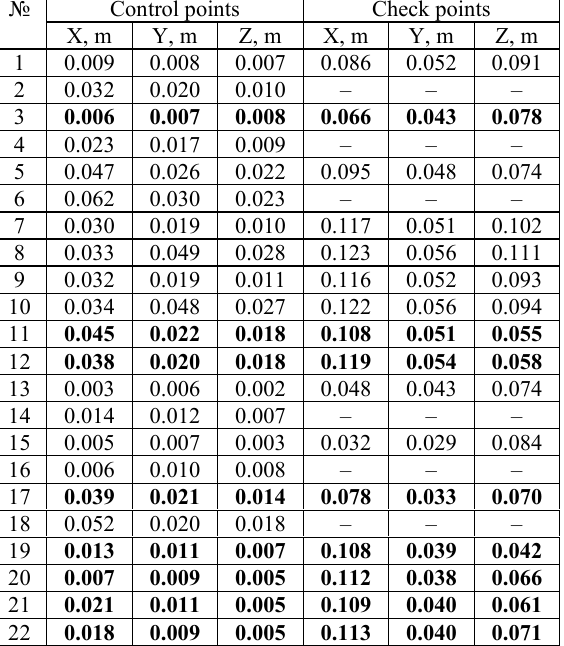
Table 3. RMS errors of generated photogrammetric models